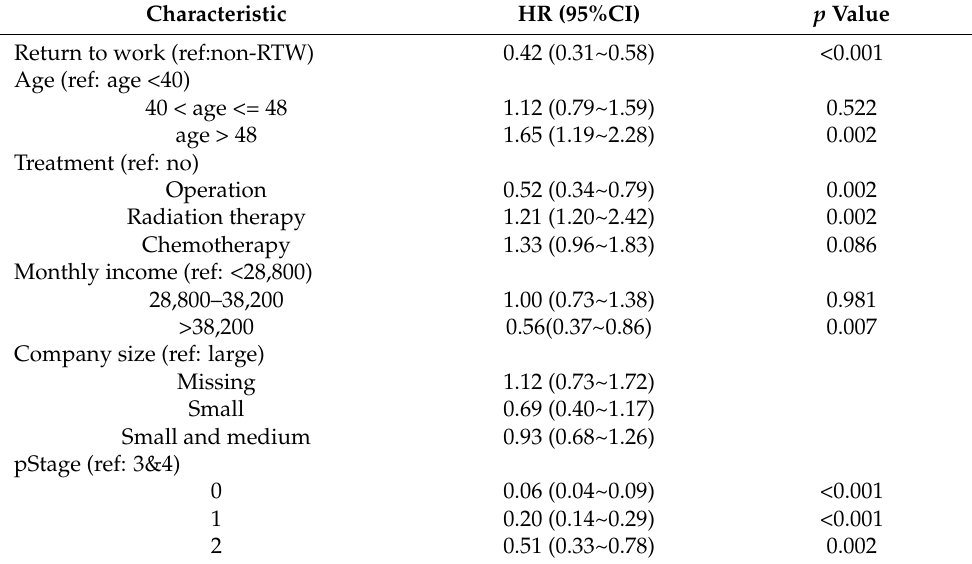
Figure 2. Kaplan-Meier curve for all-cause mortality categorized by different stages of cervical cancer. ( A ) Stage 0 of cervical cancer ( B ) Stage 1 of cervical cancer ( C ) Stage 2 of cervical cancer ( D ) Stage 3&4 of cervical cancer. Table 3. Multivariate analysis of association between independent variables and all-cause mortality of cervical cancer workers.